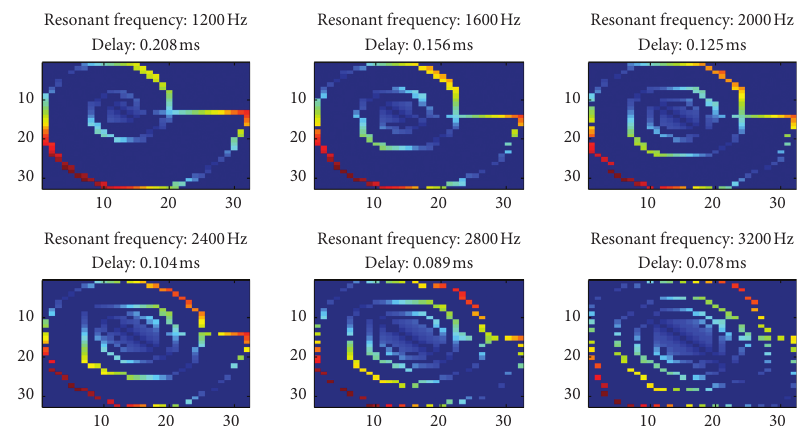
Figure 4: Mesh phase portraits of different resonant frequency fault response fragments.